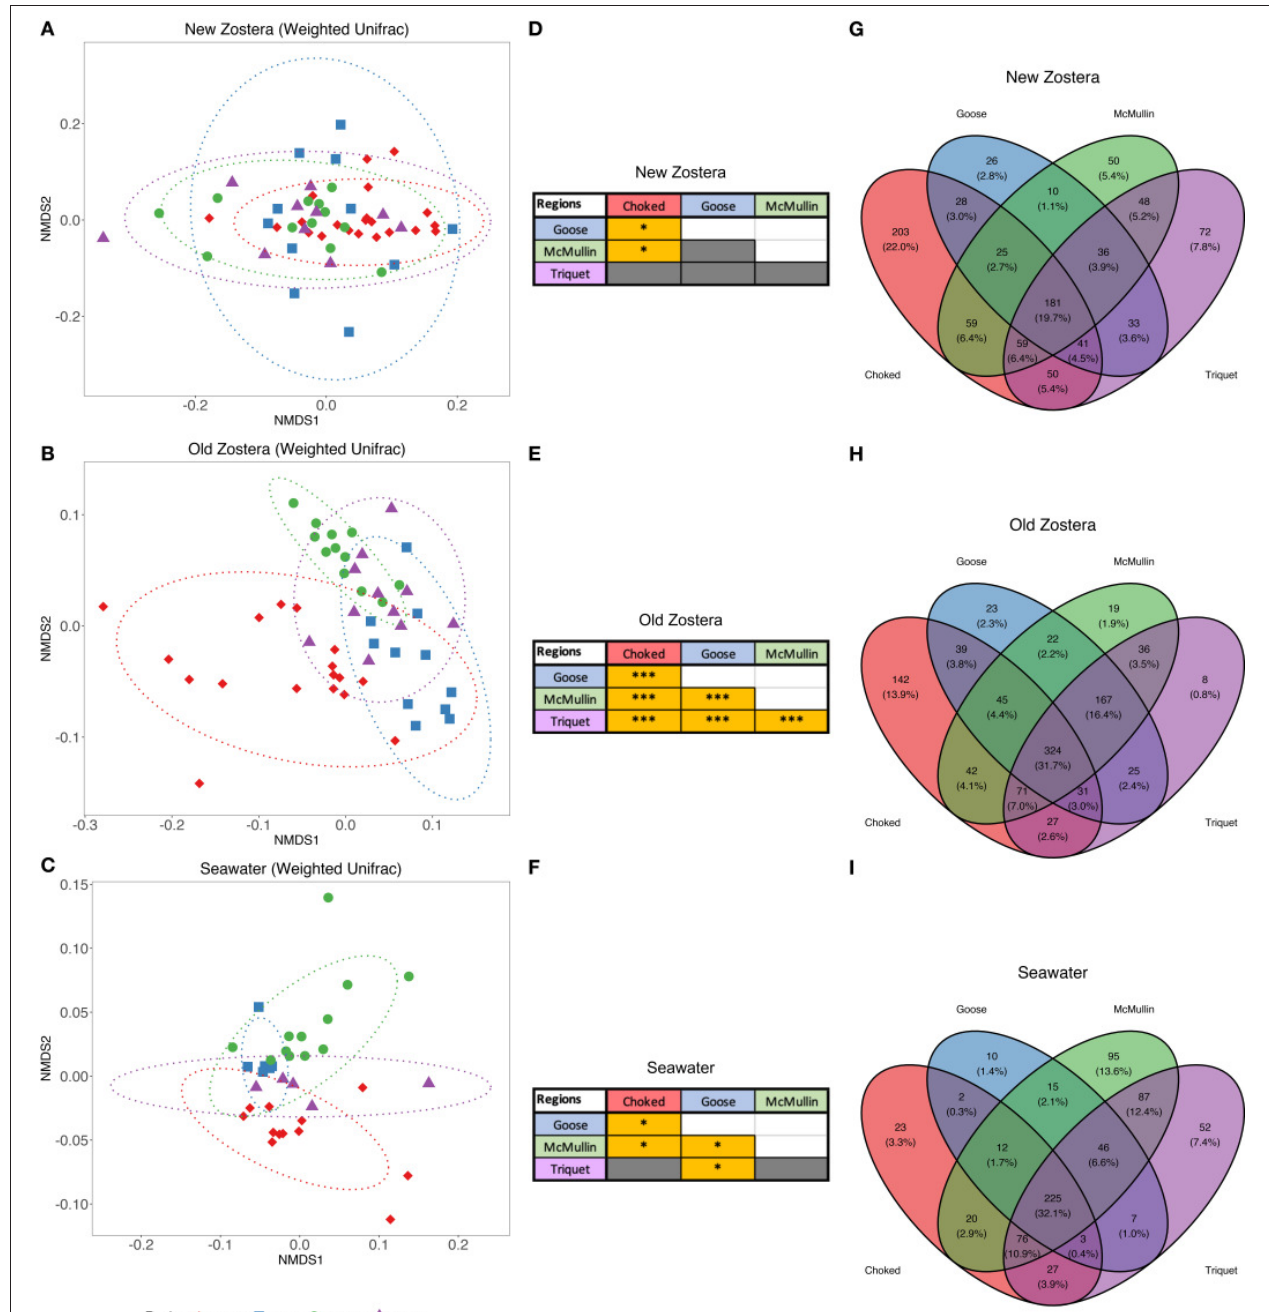
FIGURE 3 | NMDS plots based on weighted UniFrac distances, pairwise PERMANOVA results table and Venn diagrams of shared taxa of microbial communities of Z. marina new growth leaves (A,D,G) , old growth leaves (B,E,H) , and seawater (C,F,I) samples among regions. Pairwise PERMANOVA grids colored in gray are not significant, whereas grids colored in yellow are significant, where * indicates p > 0.05 and *** indicates p > 0.001. Ellipses represent ordination confidence intervals